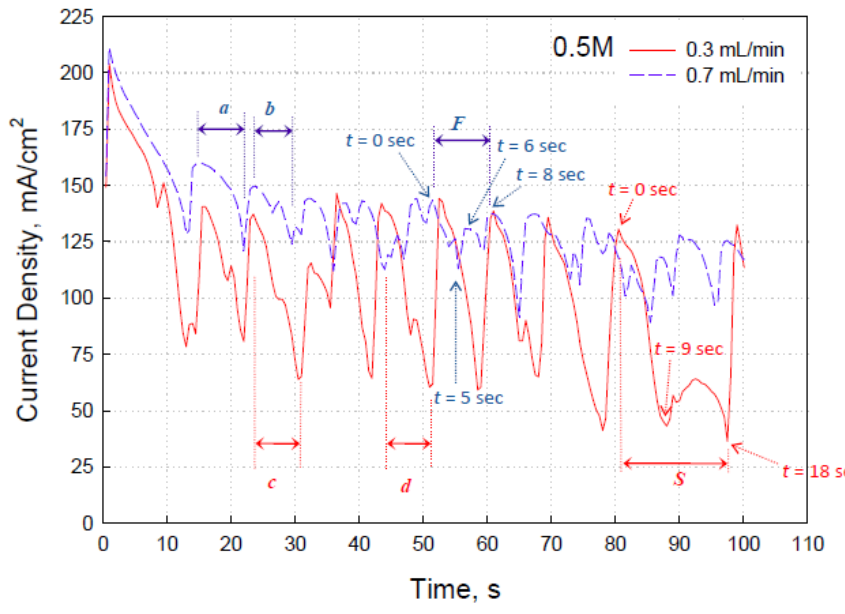
Figure 5. Current density fluctuation at 0.2 V of fuel cell during a period of time at volumetric flow of 0.3 and 0.7 mL/min with [HCOOH] = 0.5 M.